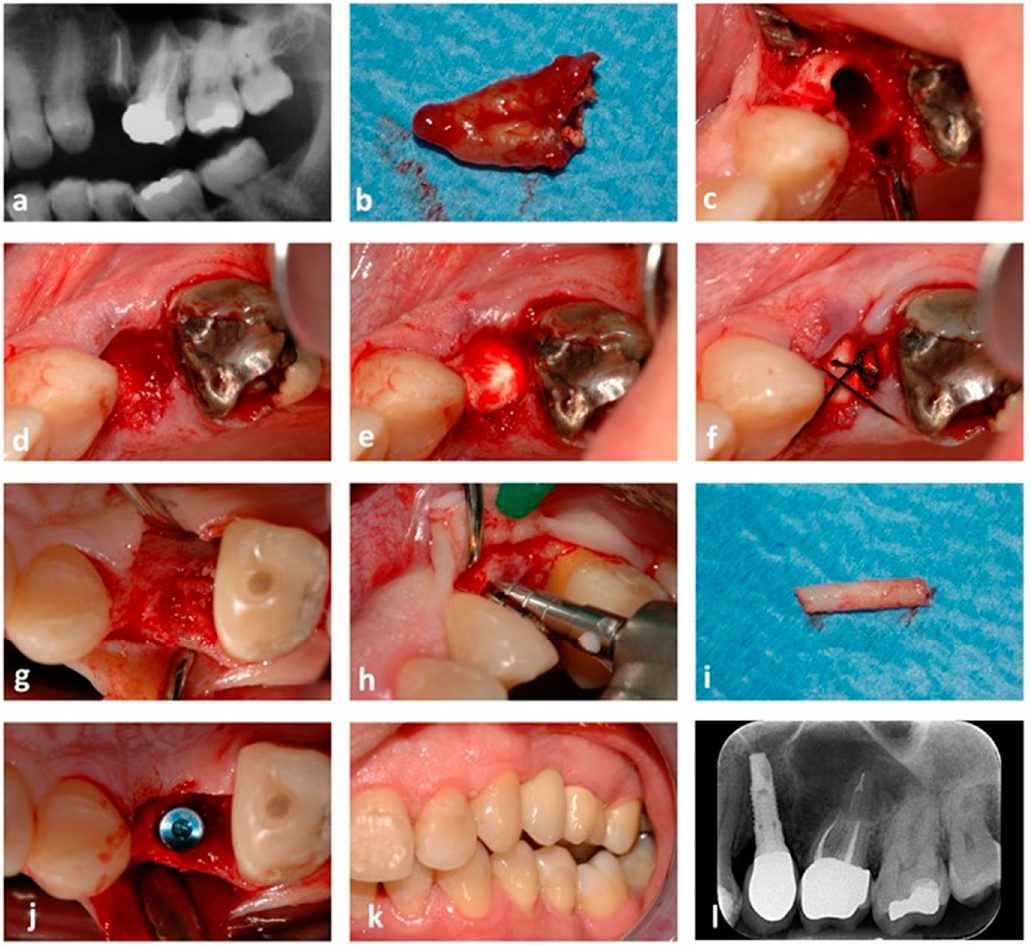
Figure 3. Post-extractive socket grafting. A case where EDEB was used is shown. ( a ) X-ray showing the initial patient status. Tooth 25 is fractured and compromised; ( b ) the element after being extracted; ( c ) the post-extractive socket before grafting; ( d ) the socket after being grafted; ( e ) a collagen membrane is placed below the gingival rims to cover the graft; ( f ) a single cross stitch stabilizes the reconstruction; ( g ) appearance of the regenerated socket 4.1 months after the grafting surgery; ( h ) a bone core is collected using a trephine bur; ( i ) the bone sample after collection; ( j ) an implant (Stone, 3.75 × 14 mm, IDI Evolution, Concorezzo, Italy) is placed into the regenerated bone; ( k ) the final prosthetic rehabilitation; ( l ) one-year control radiograph, showing maintenance of peri-implant bone levels.